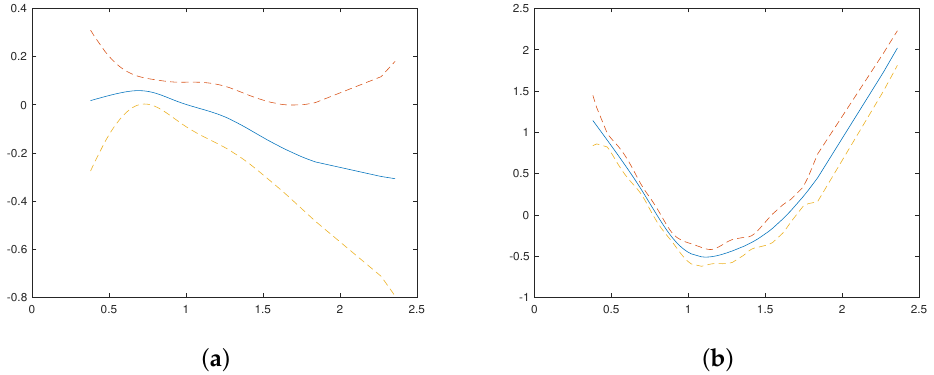
Figure 4. Plots of (cid:98) β 1 ( a ) and (cid:98) β 2 ( b ) and their approximate SE bands indicated by the discontinu- ous